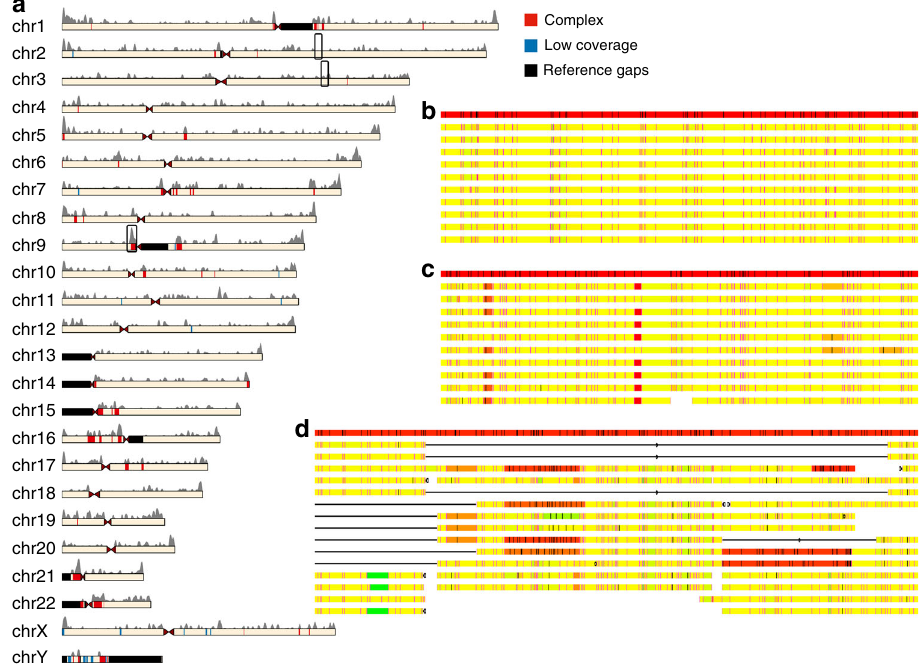
Fig. 1 Distribution and properties of large structural variations in the human genome. a Ideogram depicting the distribution of indels and complex regions. The gray histogram above the chromosomes depicts the number of indels detected in all populations using a sliding window of 1 Mb with a 10-kb step size. Chromosome fi ll shows the different regions classi fi ed in the genome. Red, structurally complex regions; blue, low individual assembly coverage; black, regions with long sequence- or nick-based gaps in the reference. For display purposes, both low-coverage and gap regions were only displayed if they were longer than 500 kb. Black boxes enclose areas shown in more detail in b – d . b Alignment of individual sample assemblies to the reference at chr2: 148.4 – 149 Mb. This region contains a low level of structural variation on the basis of both indel calls and the consensus assembly. c Alignment of individual sample assemblies to the reference at chr3: 38.4 – 39 Mb. This region contains a high density of indel calls but a low level of complex structural variation, and was categorized as low complexity. d Alignment of individual sample assemblies to the reference at chr9: 42 – 42.9 Mb. This pericentromeric region has complex structural variation as well as many indels. In b – d , the red bar at top is the reference nick pattern and the bars below are consensus maps from 10 random samples. Yellow segments are highly similar to the reference, while green or red segments are shorter or longer than the corresponding reference segments, respectively, where intensity of color correlates positively with difference from the reference. Red lines represent aligned labels and black lines represent unaligned labels. Circles denote inversions while squares at the ends of contigs denote translocation break